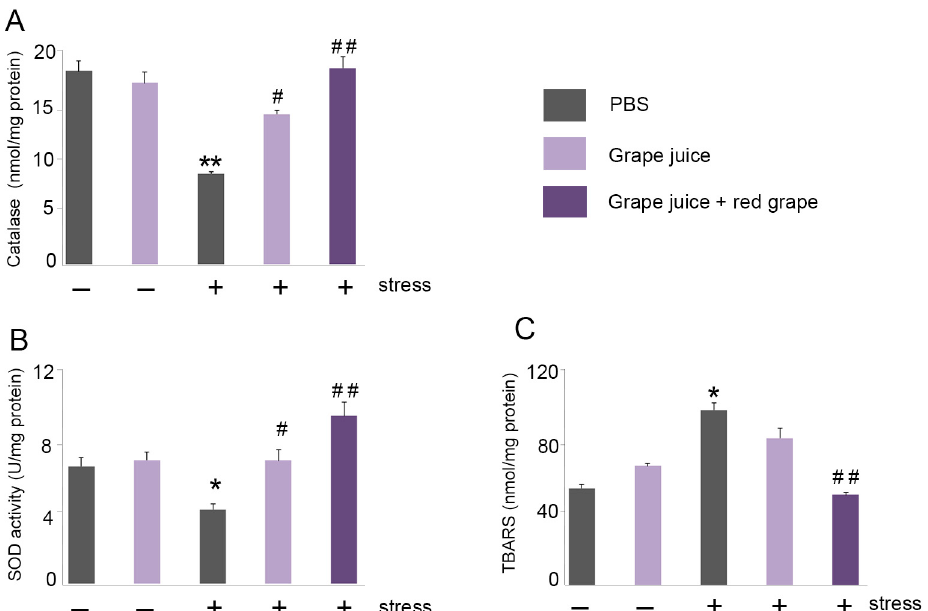
Figure 5. Grape juice enriched with red grape polyphenols increases the activity of antioxidant enzymes. Mouse brains were isolated and catalase activity ( A ), SOD activity ( B ), and TBARS ( C ) were analyzed. Values are presented as mean ± SEM from at least five independent animals. One-way ANOVA and Dunnet’s multiple comparison post hoc test were used for statistical analysis. * p < 0.05; ** p < 0.01 vs. normal mice; # p < 0.05, ## p < 0.01 vs. stressed mice. Abbreviations: SOD: superoxide dismutase.